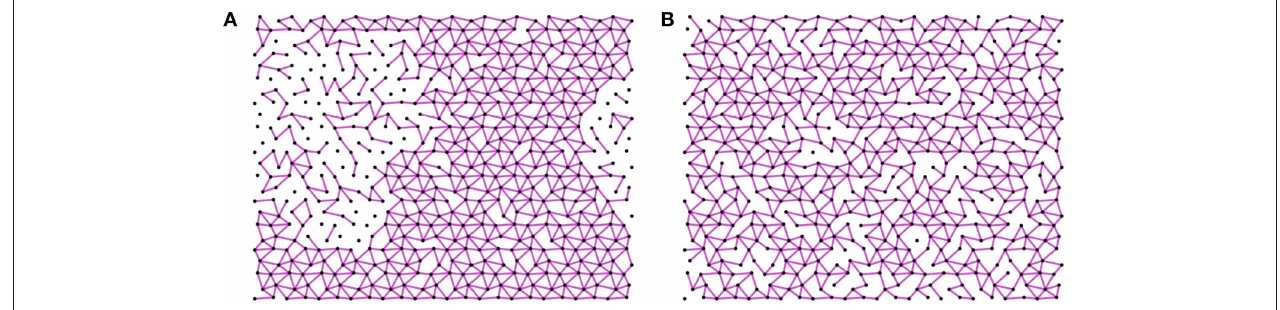
FIGURE 2 | Snapshot of the system above (A) and below (B) the critical temperature for a system of 576 particles with the constraint number n = 2.06 > n c . The purple lines represent the springs. (A) Heterogeneous structure: At high temperature T = 10, the entropy dominates over the internal stress energy, in particular, the vibrational entropy maximizes by phase separating into rigid and floppy regions. (B) Homogeneous structure: At low temperature T = 0.001 the energy of the inherent structures dominates over the internal energy, this energy minimizes by a homogeneous distribution of constraints.